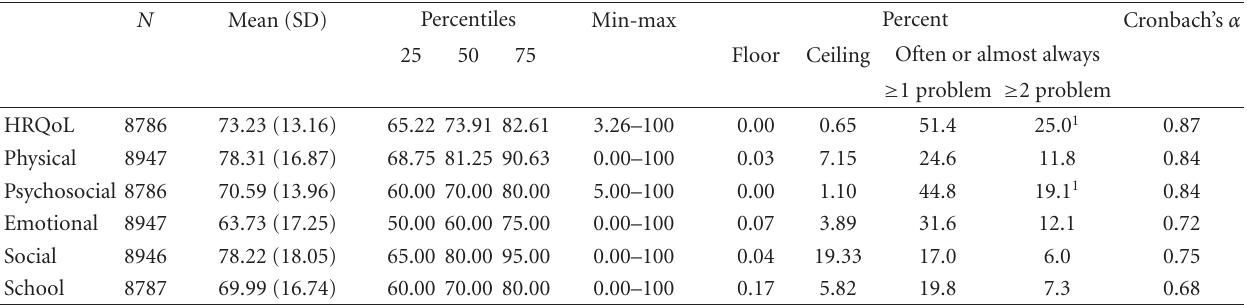
Table 2: Self-rated health-related quality of life (HRQoL) and subdomains of HRQoL in 12–18-year-old school children in Fiji.